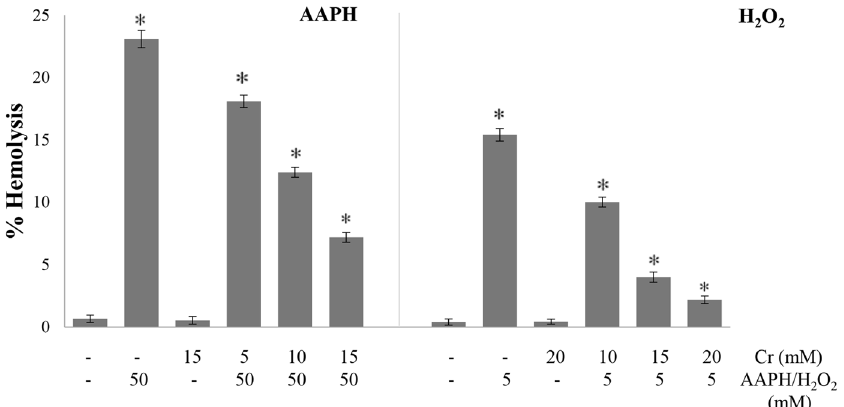
Fig 1. Effect of creatine on AAPH/ H 2 O 2 -induced hemolysis of erythrocytes. Erythrocytes were treated with the indicated concentrations of H 2 O 2 /AAPH, in presence and absence of Cr. After centrifugation, hemolysis was determined from the absorbance of supernatants as described in Materials and Methods. Results are mean values ± SEM from six independent experiments using blood from different donors. * Significantly different from control (p <